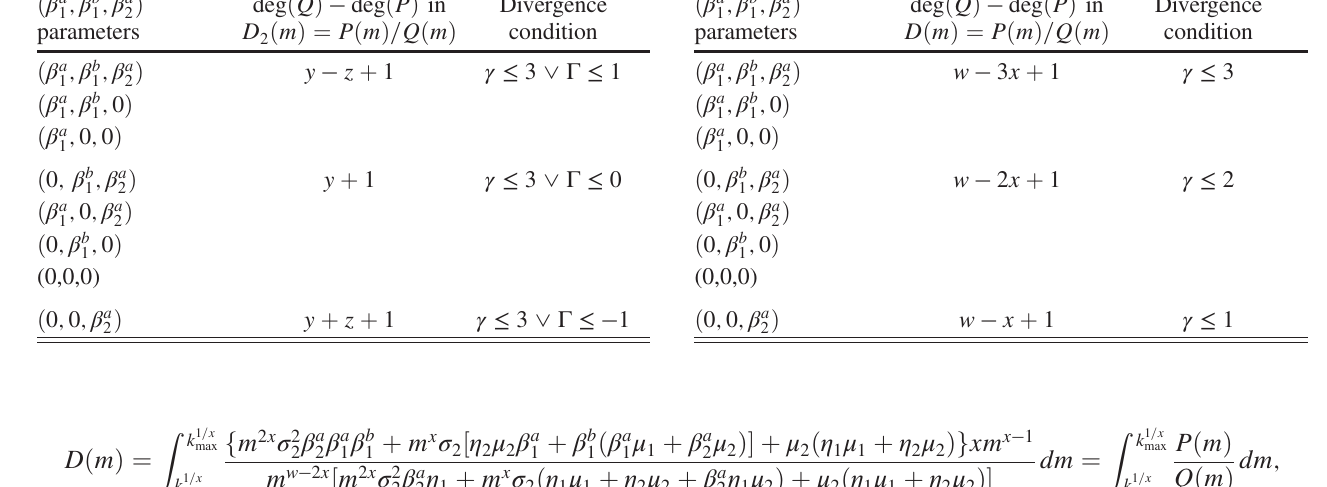
TABLE V. Divergence conditions for